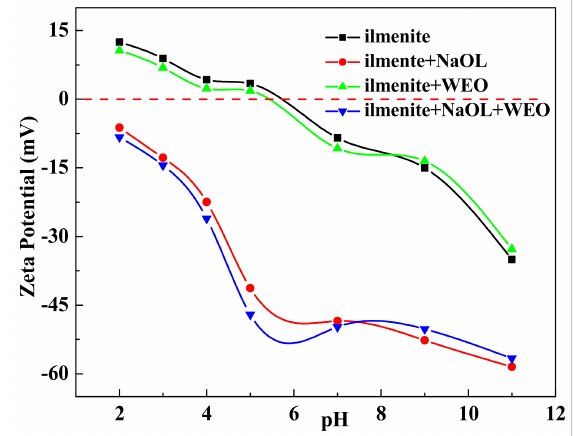
Figure 3. Effect of pH on zeta potentials of ilmenite treated by NaOL or/and the WEO.